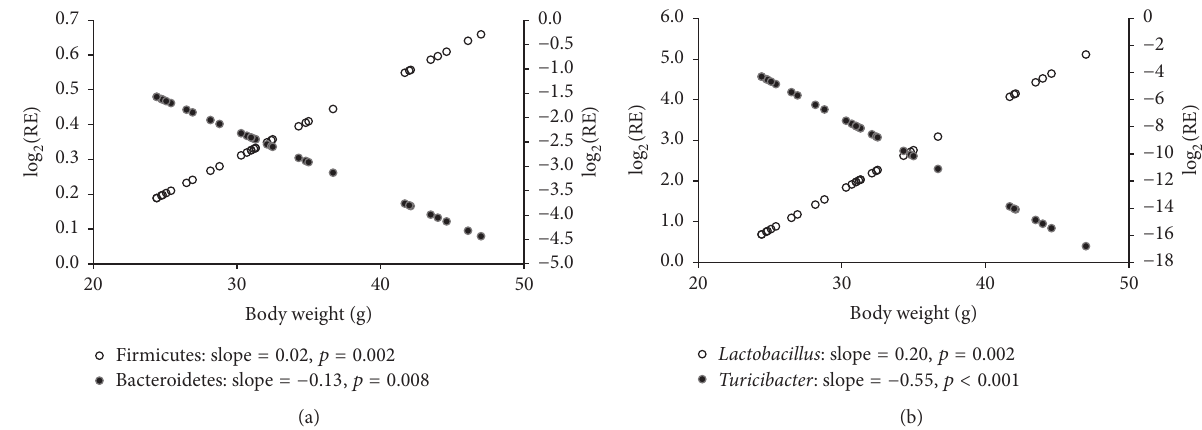
Figure 2: Correlations of body weight with abundances of gut microflora. (a) At the phylum level, the abundance of Firmicutes was positively associated with body weight, whereas the abundance of Bacteroidetes was negatively associated with body weight. (b) At the genus level, the abundance of Lactobacillus was positively associated with body weight, whereas the abundance of Turicibacter was negatively associated with body weight.